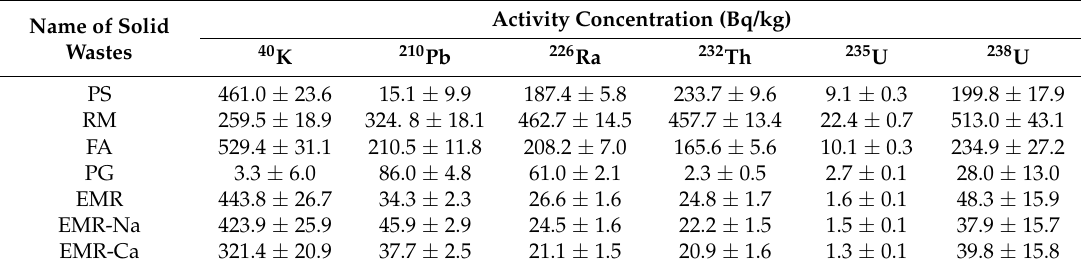
Table 4. The activity concentrations (Bq/kg) of six nuclides for the seven solid